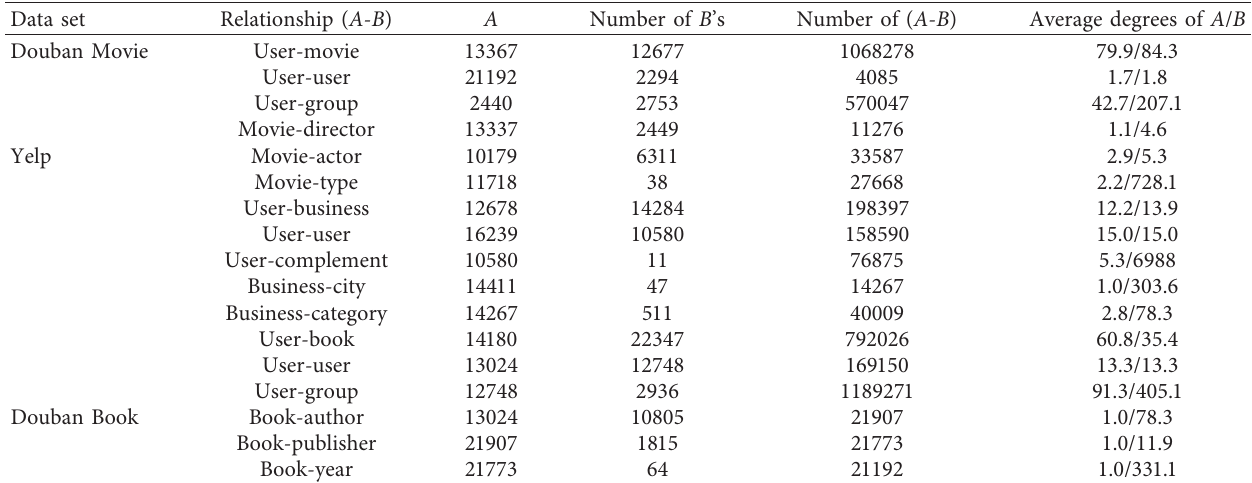
Table 2: Statistics of data